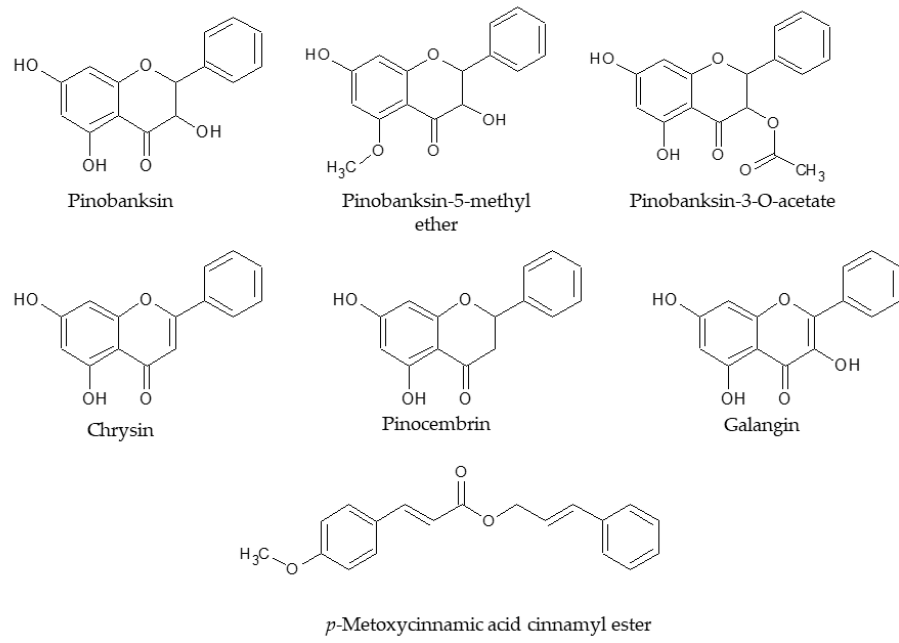
Figure 1. Structure of components connected with the anti- Helicobacter activity of propolis extracts.